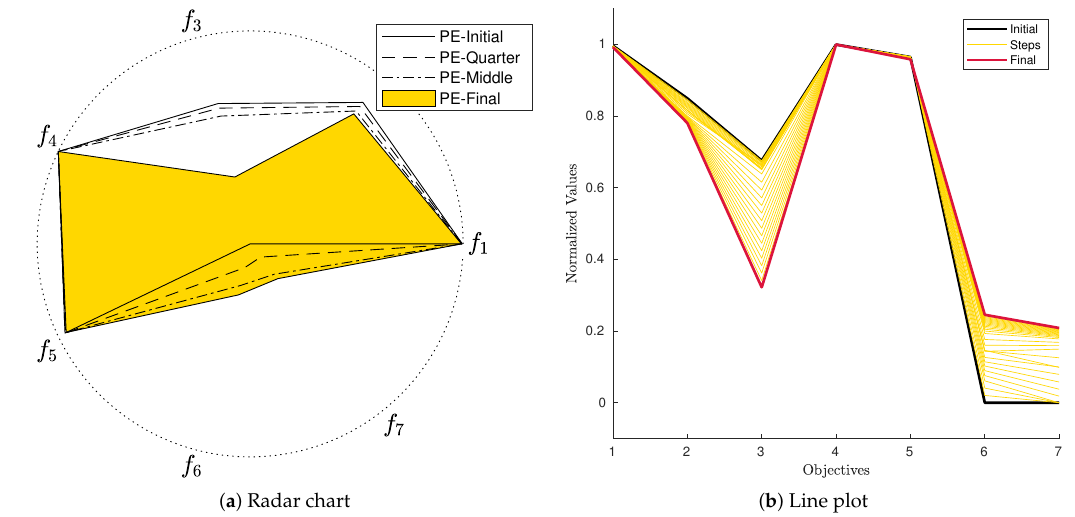
Figure 12. Numerical results of PE for the plastic injection molding